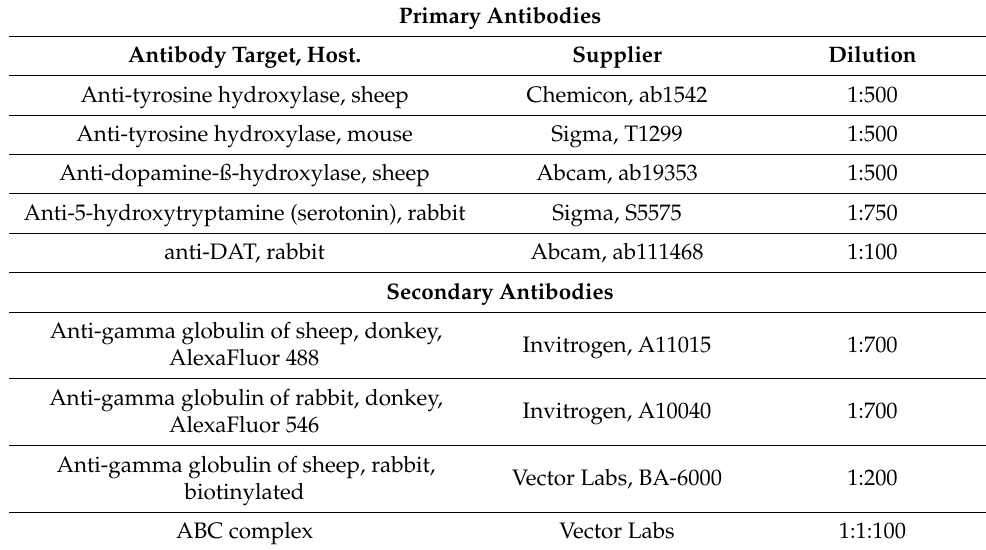
Table 1. Primary and secondary antibodies used in these immunocytochemical studies. Primary